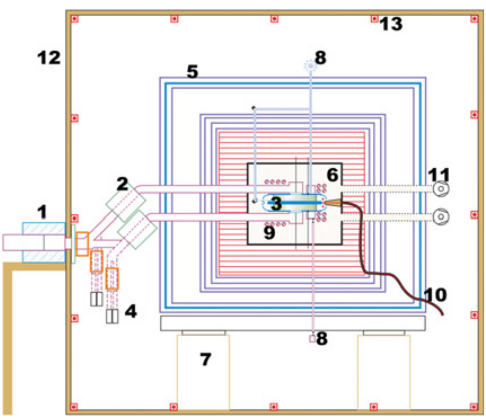
Figure 1. Experimental apparatus. The UCN coming from the source are polarized after passing a 5 T superconducting polarizer magnet (1). Two switches (2), containing each 2 UCN guides are used to fill and empty the UCN chambers (3). After a typical precession time of 180 s, the UCN are counted in the detectors (4). The storage chambers and the vacuum vessel (6) are in a magnetically shielded room (5), which rests on an Aluminum frame supported by four granite pillars (7). The magnetic field is monitored in situ with a Hg system (8) and a Cs magnetometer array (9). The high voltage is provided via a cable (10) and the vacuum vessel is pumped with turbo molecular pumps situated outside of the magnetically shielded room (11). The entire setup is inside an insulation shell, thermally stabilized by air-conditioning (12). A surrounding field compensation (SFC) system will actively reduce the magnetic perturbations of the environment